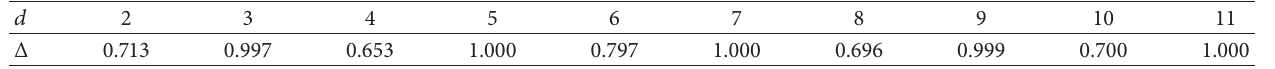
( n ) for d ∈ 2 , 3 , ... , 11 { } p